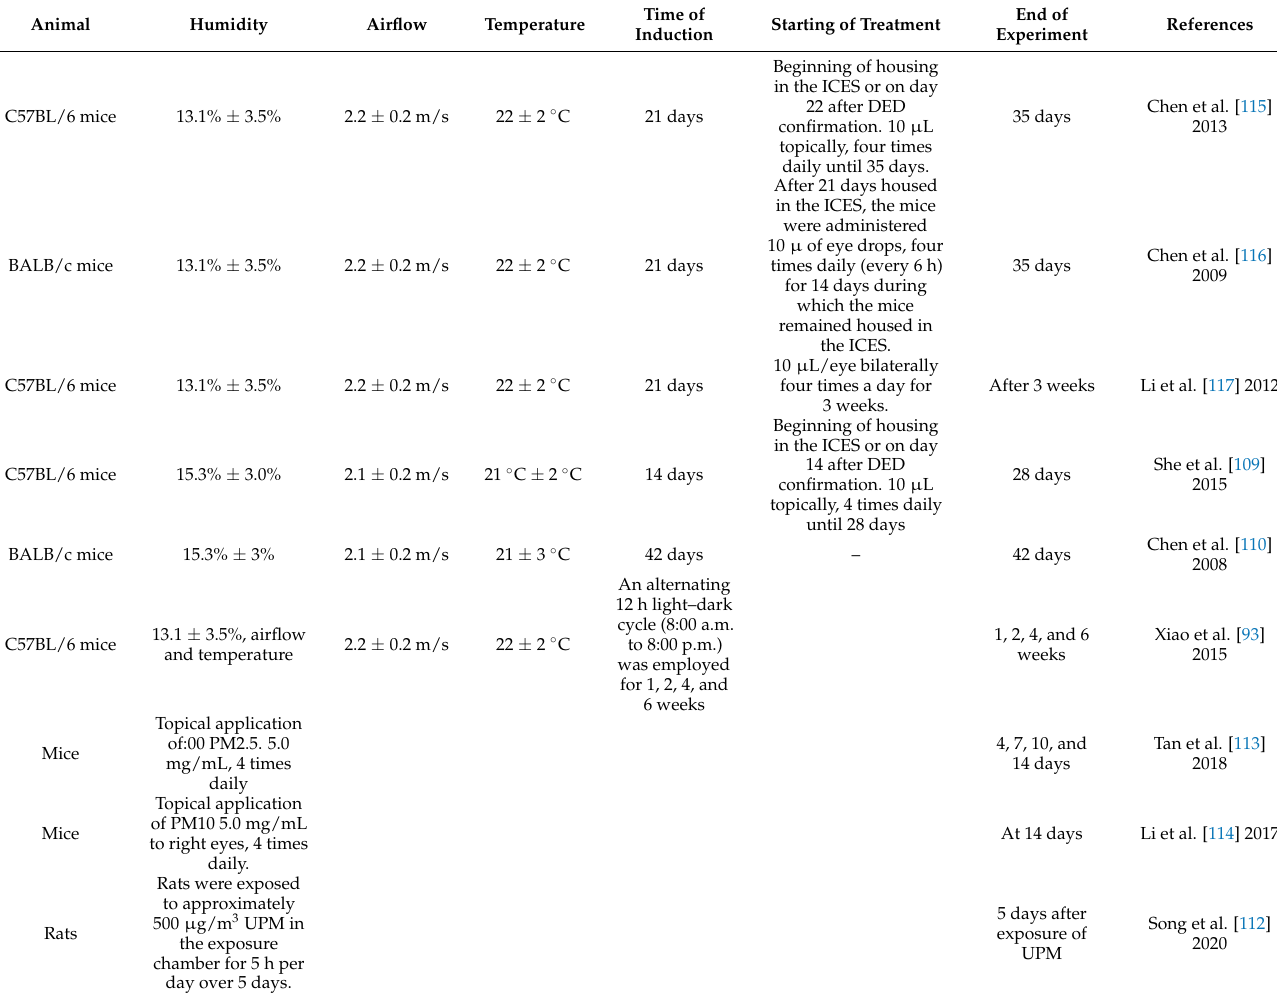
Table 5. Environmental factors-induced DED model and experiment